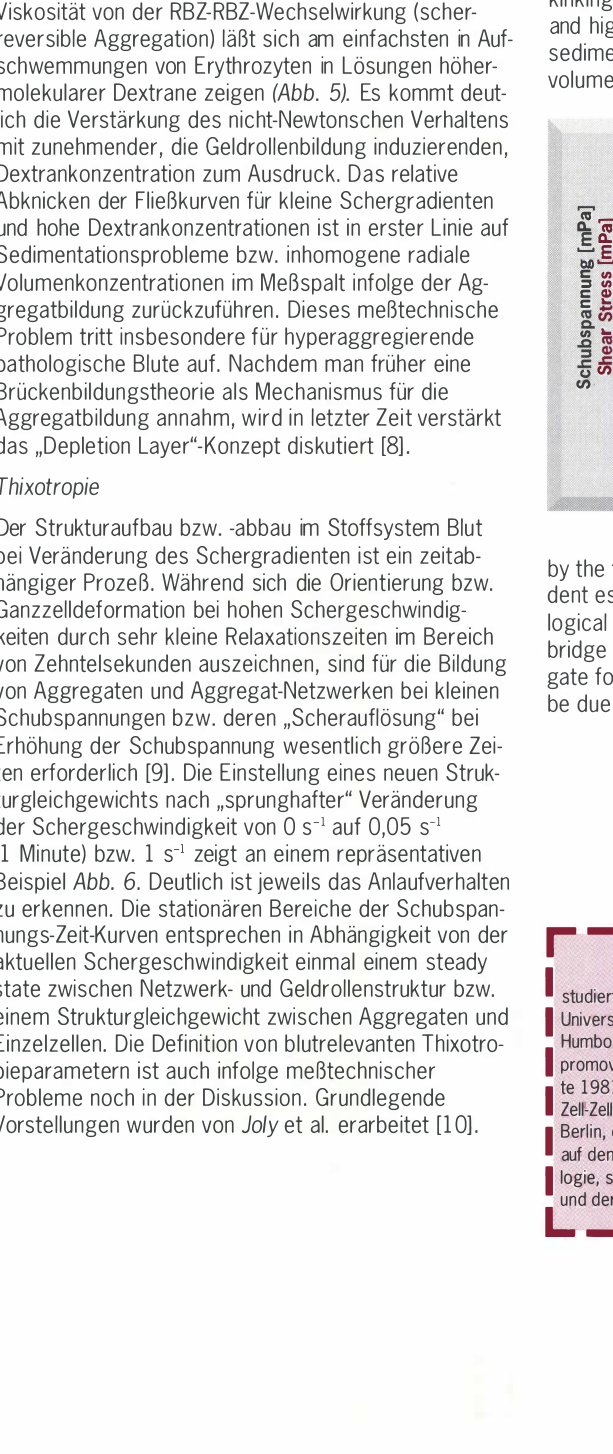
Fig. 5: Flow curves for eryth­ rocytes suspended in dex­ trane electrolyte solutions (PBS) of different dextrane concentration . The great dependence of the apparent absolute vis­ cosity on the interaction between the red blood cor­ puscles (shear-reversible aggregation) can be most easily demonstrated by suspensions of erythrocytes in solutions of high molecular weight dextranes (fig.5). There is a distinct increase in non-Newtonian behaviour with increasing dextrane concentration. The relative kinking of the flow curves for small shear gradients sedimentation problems and inhomogeneous radial